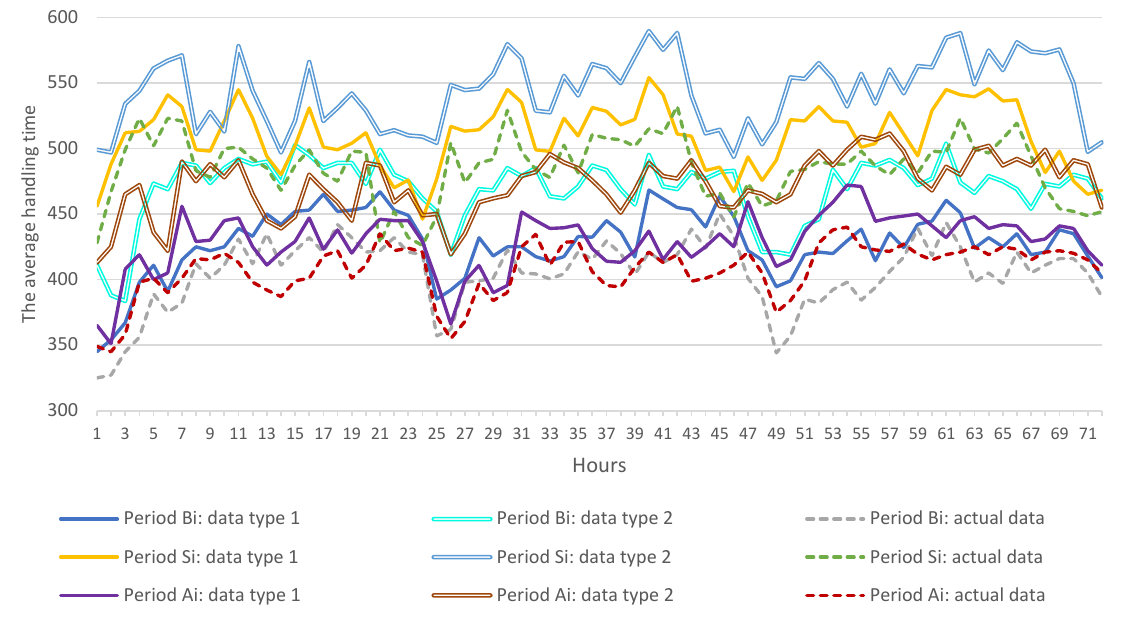
Figure 7. The average handling time on two data types with actual data. In the final step, the number of agents was classified in two categories: (1) service level classification for data type 1; and (2) the existing service level for data type 2. For the service level classification, we selected the number of calls from the best forecasting. Table 8 shows the incoming call forecasting classified into three categories. The results are shown in the same class for the same periods: Category 1 for internet and promotion,